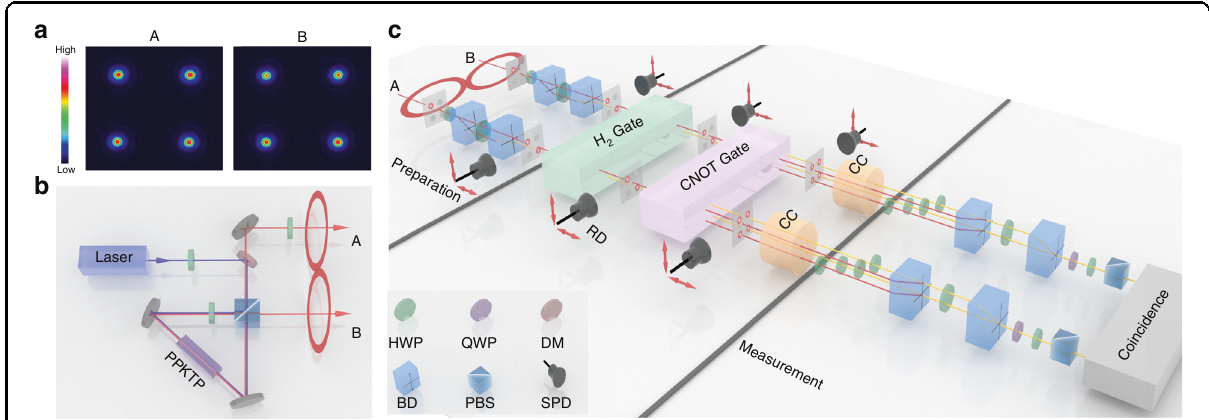
Fig. 2 Experimental setup for veri fi cation of fault-tolerant threshold in quantum circuits. a Experimental images of optical spatial modes on sides of A and B is generated by exploiting a group of several beam displacers (BDs) and half-wave plates (HWPs). b The unit to prepare entangled photon pairs. c Spatial mode evolutions of fault-tolerant circuits including the stages of preparation, logical operations (H 2 and CNOT 21 ), and measurement. Output spatial modes on each side of every stage are detected with removable detectors (RDs), which are built with single-photon detectors (SPD) placed on two-dimensional movable platforms, for coincidence counts to estimate the imported error rate. Final spatial modes on each side are combined together, where optical path differences among the modes on each side are offset by compensation crystals (CC), and then measured with a quarter-wave plate (QWP), an HWP, and a polarization beam splitter (PBS). The coincidence device deals with the detected signals from two sides and outputs the coincidence